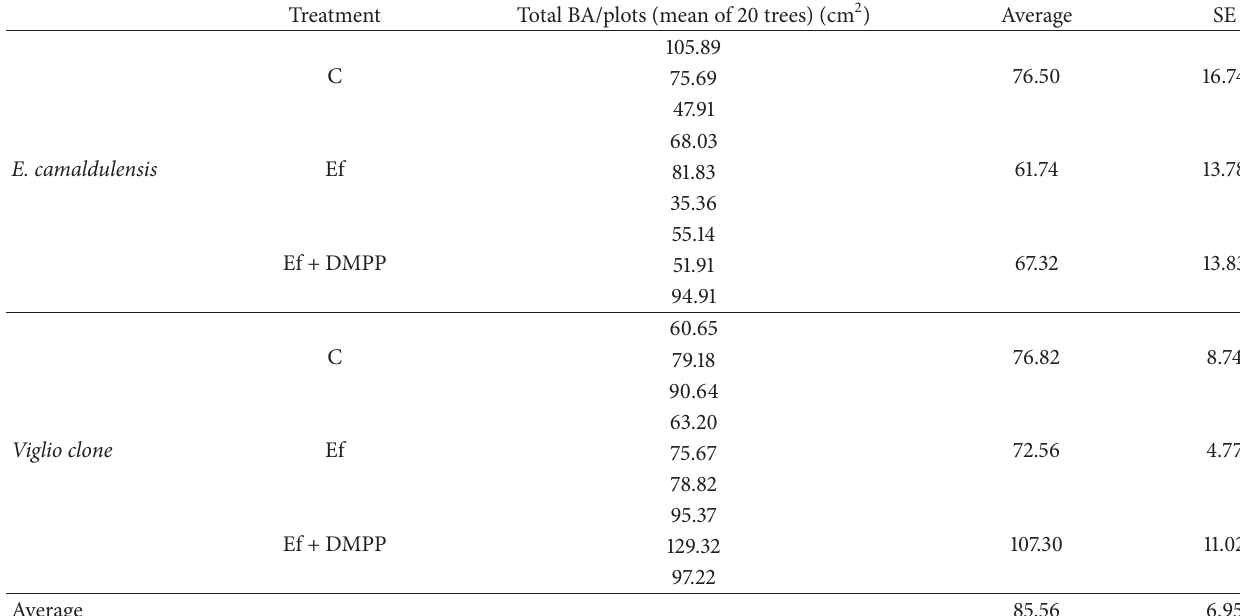
Table 2: Basal area (BA) in cm 2 of E. camaldulensis and E. camaldulensis × E. bicostata (Viglio clone). Data were collected on 20 trees for each plot replicates, standard errors are also